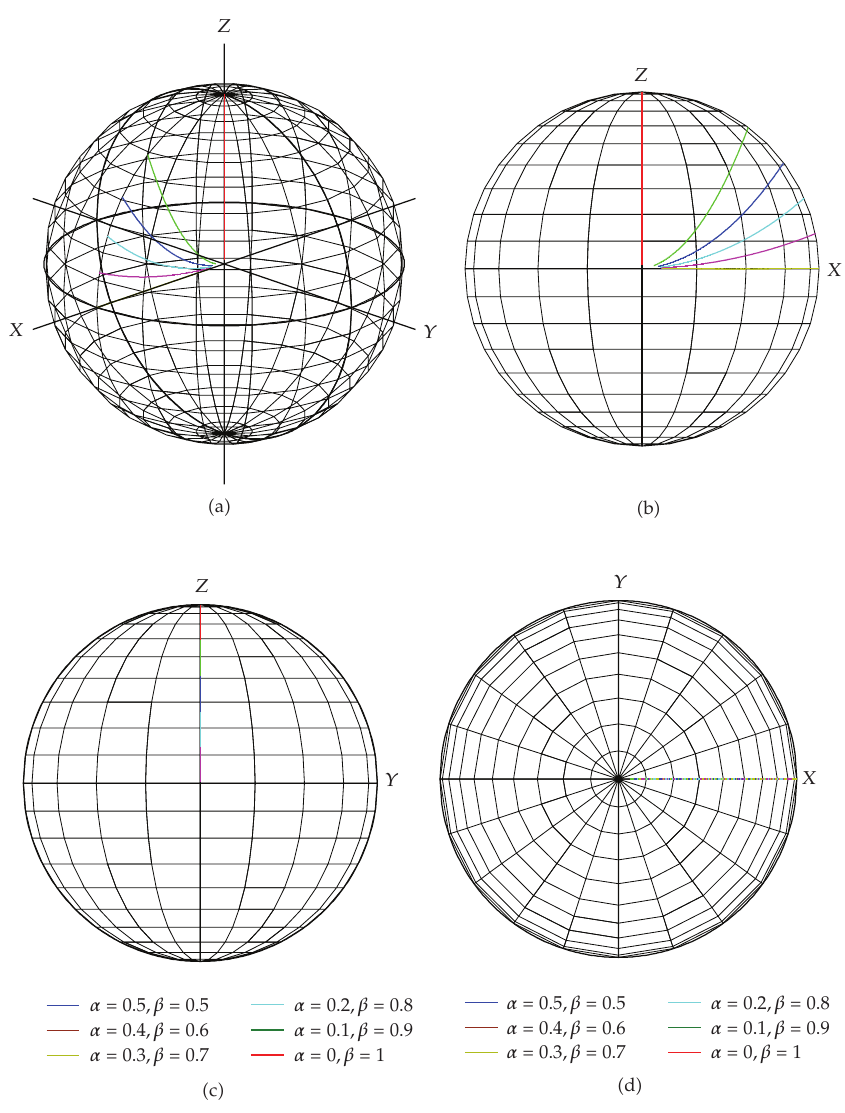
Figure 17: Excess electron spin dynamics on the bloch sphere for large Δ